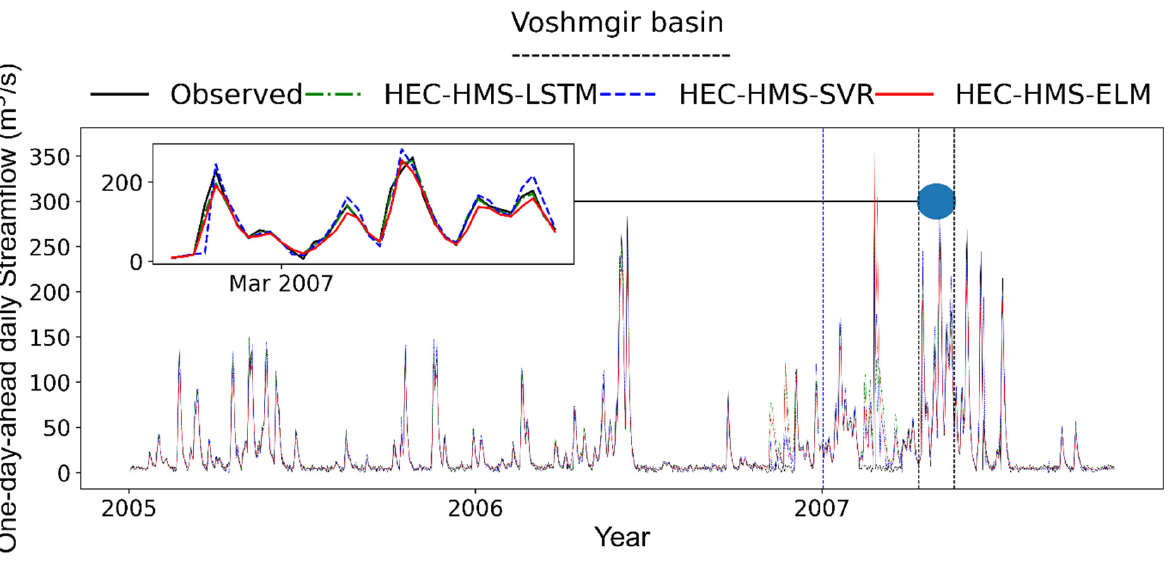
Figure 8. The scatter plots of one-day streamflow forecasting in the validation step: ( a ) LSTM model; ( b ) SVR model; ( c ) ELM model.